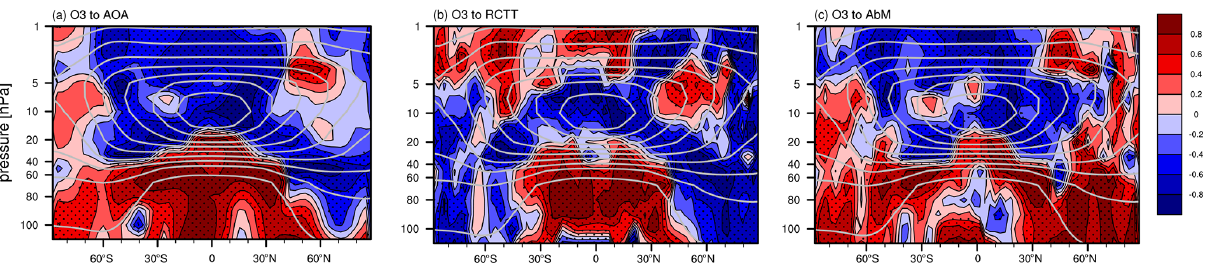
Figure 7. Inter-model correlation coefficients between local ozone trends and (a) local AoA trends, (b) local RCTT trends, and (c) local AbM trends. Trends are calculated over the period 1998–2018 for a subset of nine REF-C2 model simulations. White contours show the MMM ozone climatology, and the stippled regions mark where correlation coefficients are significant on the 95%